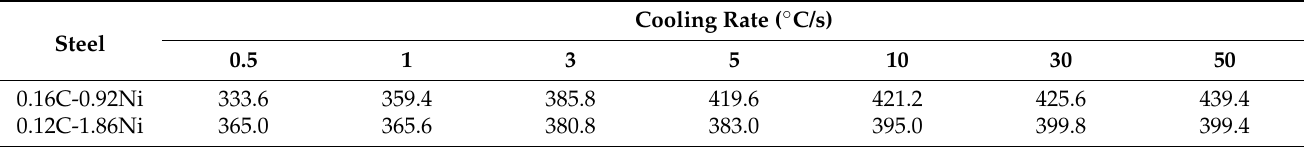
Table 2. Vickers hardness of two steels at different cooling rate (HV 1